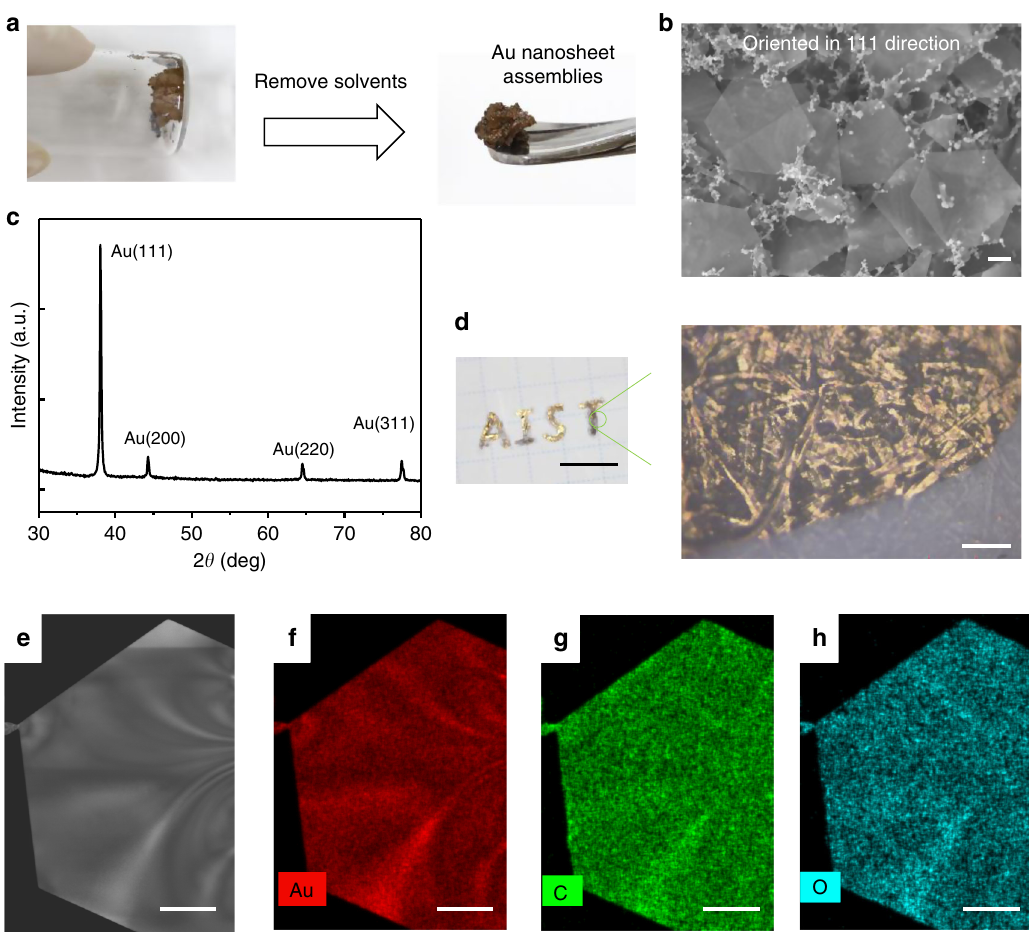
Fig. 3 Morphological, structural and compositional characterizations. a The gold nanosheet aggregates were collected after removing the solvents by pipette. b Scanning electron microscopy image of the collected microscale (~5 μ m) nanosheet aggregates. The bottom nanosheet can be seen from the top sheet, indicating its optical transparency. Scale bar: 1.0 μ m. c X-ray diffraction pattern of the gold nanosheets. d The nanosheets were used as a paste to write characters on paper and observed under a re fl ection microscope. Scale bars: 1.0 cm (left); 100 μ m (right). e − h Energy-dispersive X-ray spectroscopy elemental maps for Au (red), C (light green), and O (light blue) obtained from a gold nanosheet. Scale bars: 300